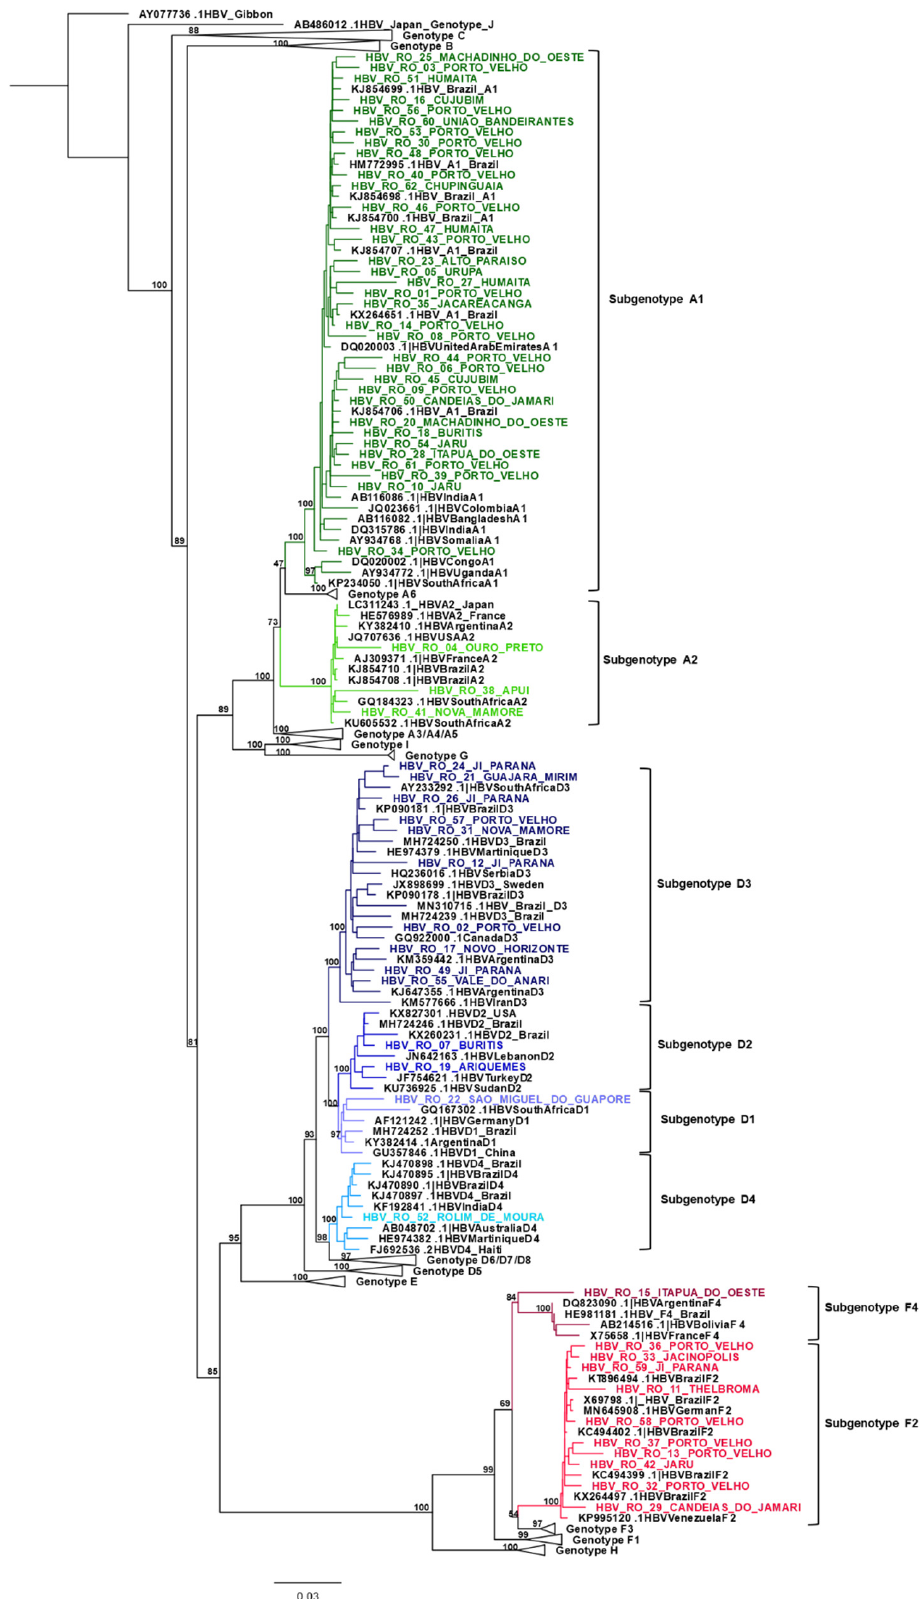
Figure 1. Maximum likelihood phylogenetic tree of all samples enrolled in this study (n = 62). Colours represent a genotype/subgenotype clade. Reference sequences (n = 147) are displayed in black.